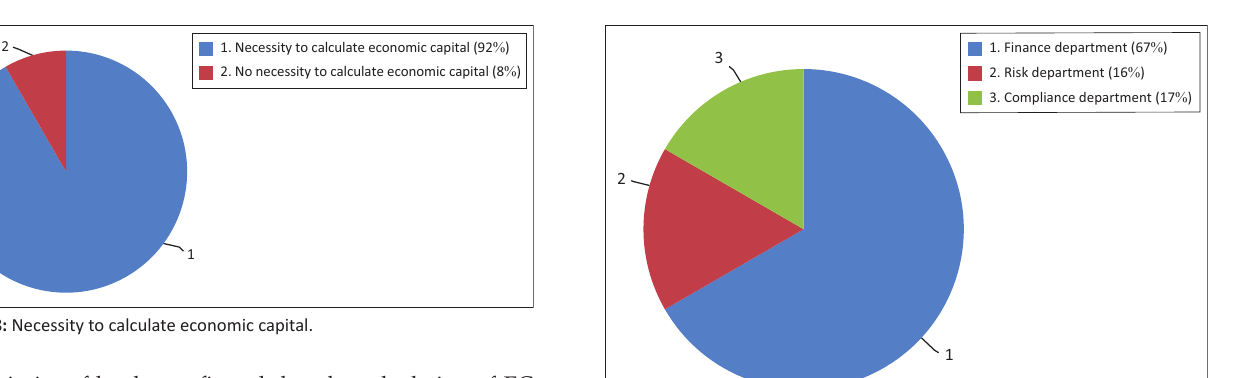
Figure 9 indicates bank departments responsible for the calculations mentioned in ‘Calculation of economic capital’ section above.